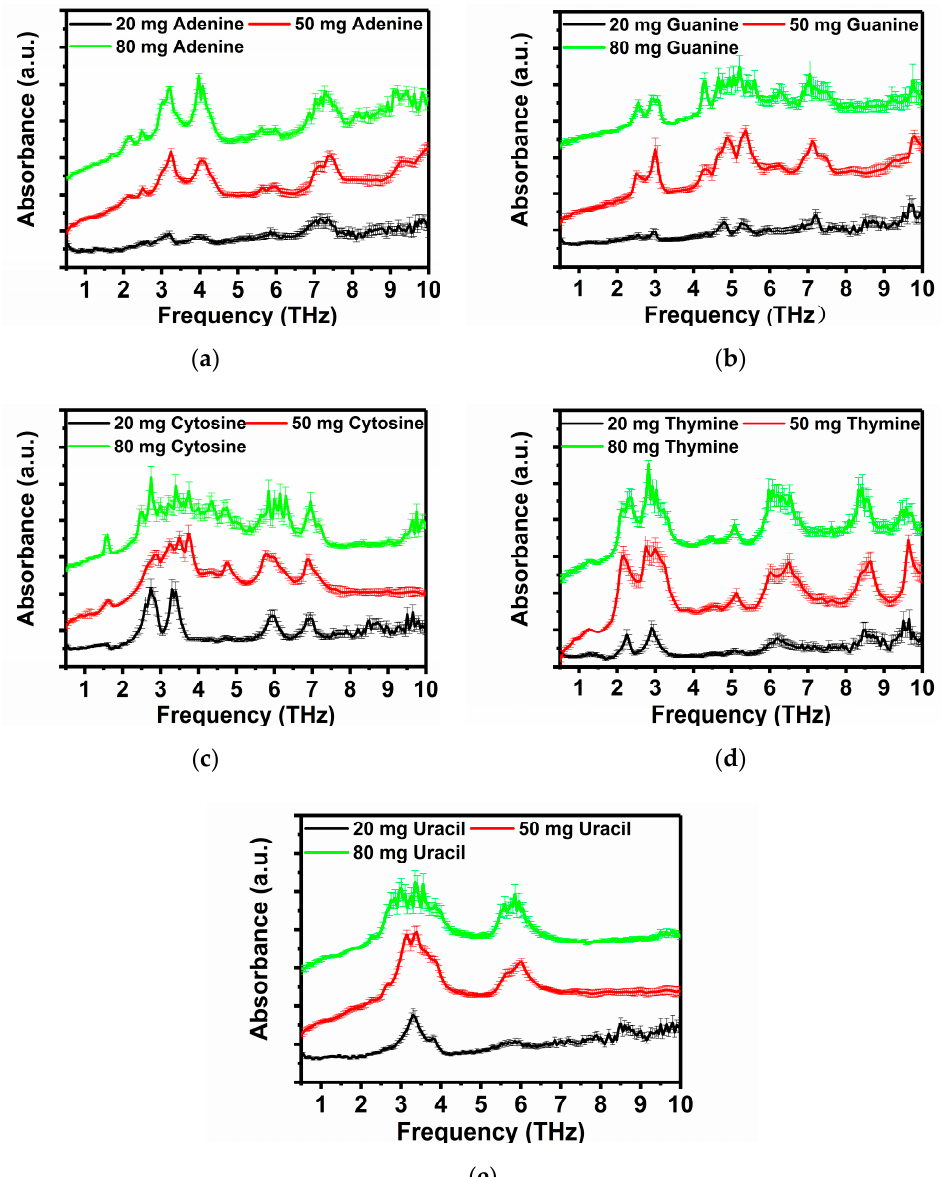
Figure 4. Absorption spectra of DNA/RNA nucleobases with three different mass. ( a ) Adenine; ( b ) Guanine; ( c ) Cytosine; ( d ) Thymine; ( e ) Uracil.